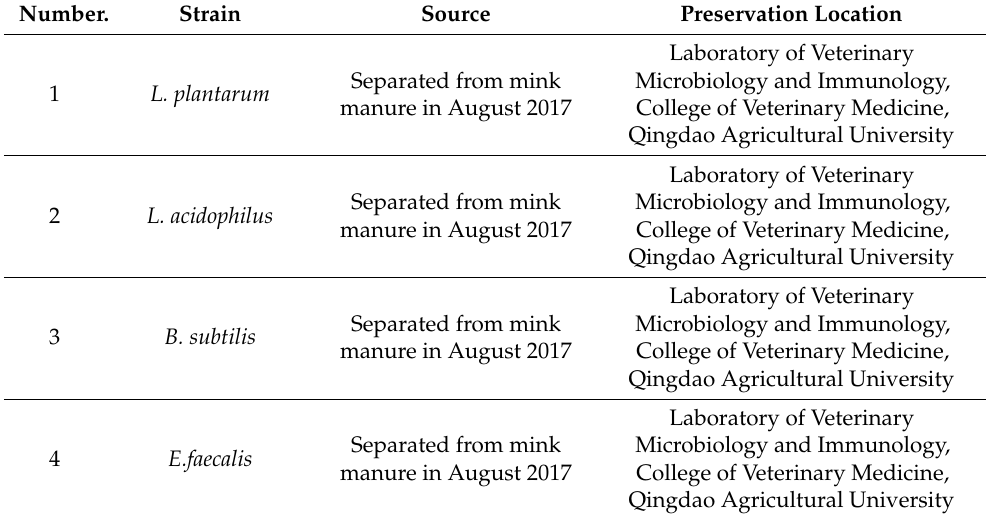
Table 1. Information on strains used in the experiment. Number. Strain